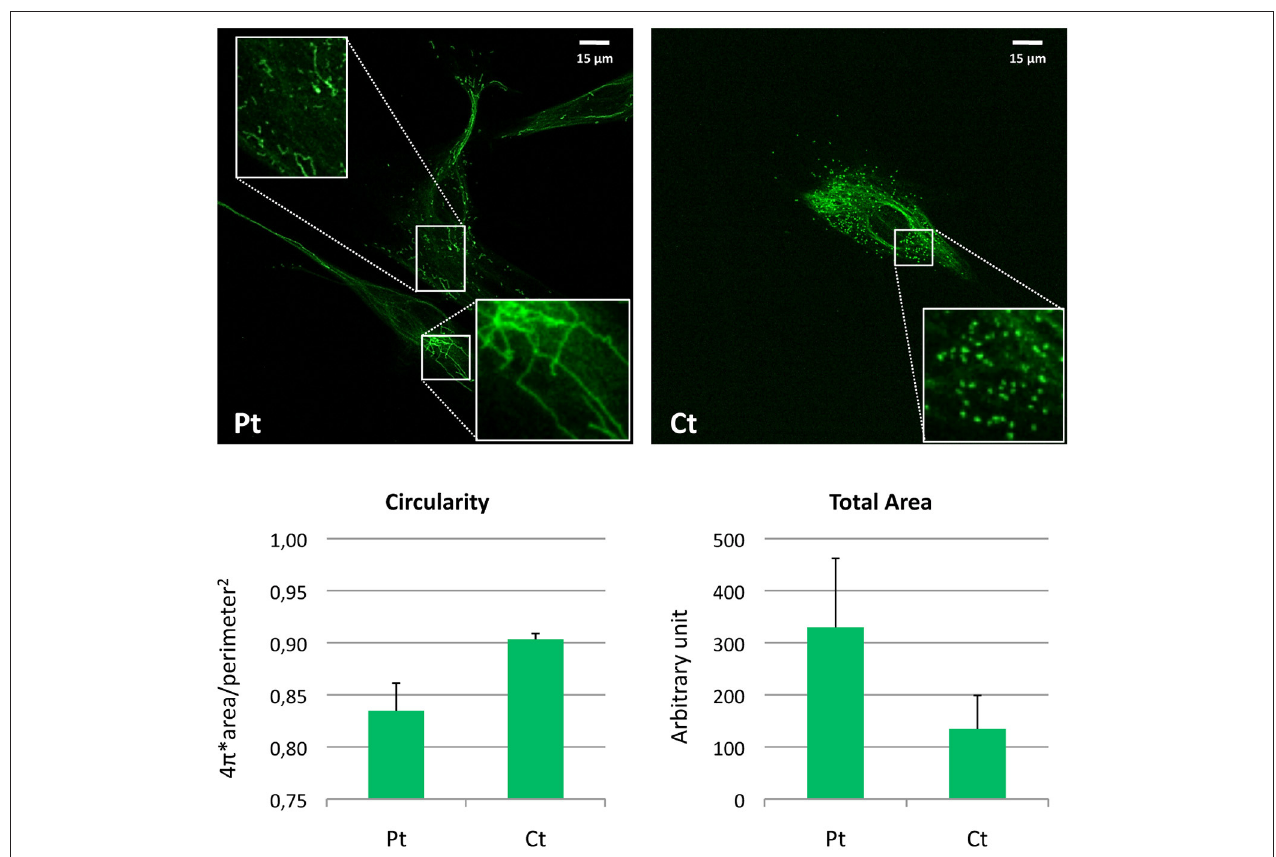
FIGURE 4 | Morphometric analysis of peroxisomal staining in patient fibroblasts. Immunofluorescence staining with the anti-PMP70 antibody in fibroblasts from the patient (Pt) and a control subject (Ct). In the insets, a digital magnification (3x) better shows the altered peroxisomal morphology observed in Pt cells. Scale bar: 15 µ m. Analysis of the shape factor (circularity) and mean area of the peroxisomal staining in fibroblasts from Pt and Ct are reported in the graphs. Data are presented as mean ± SD.